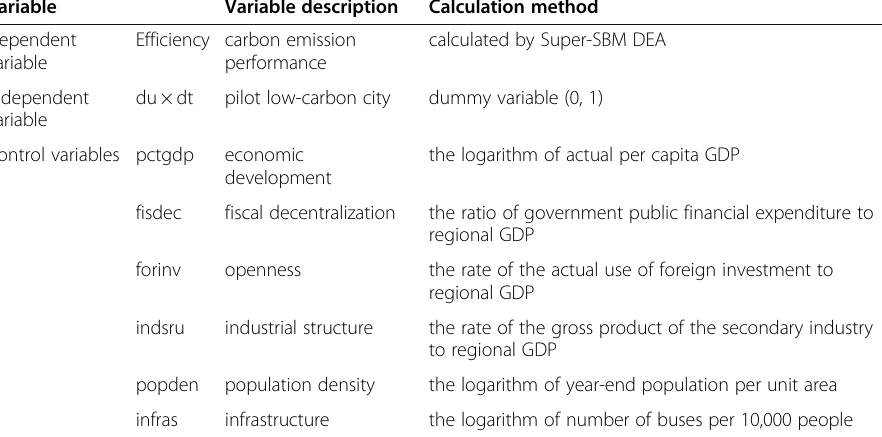
Table 1 Key variables and calculation